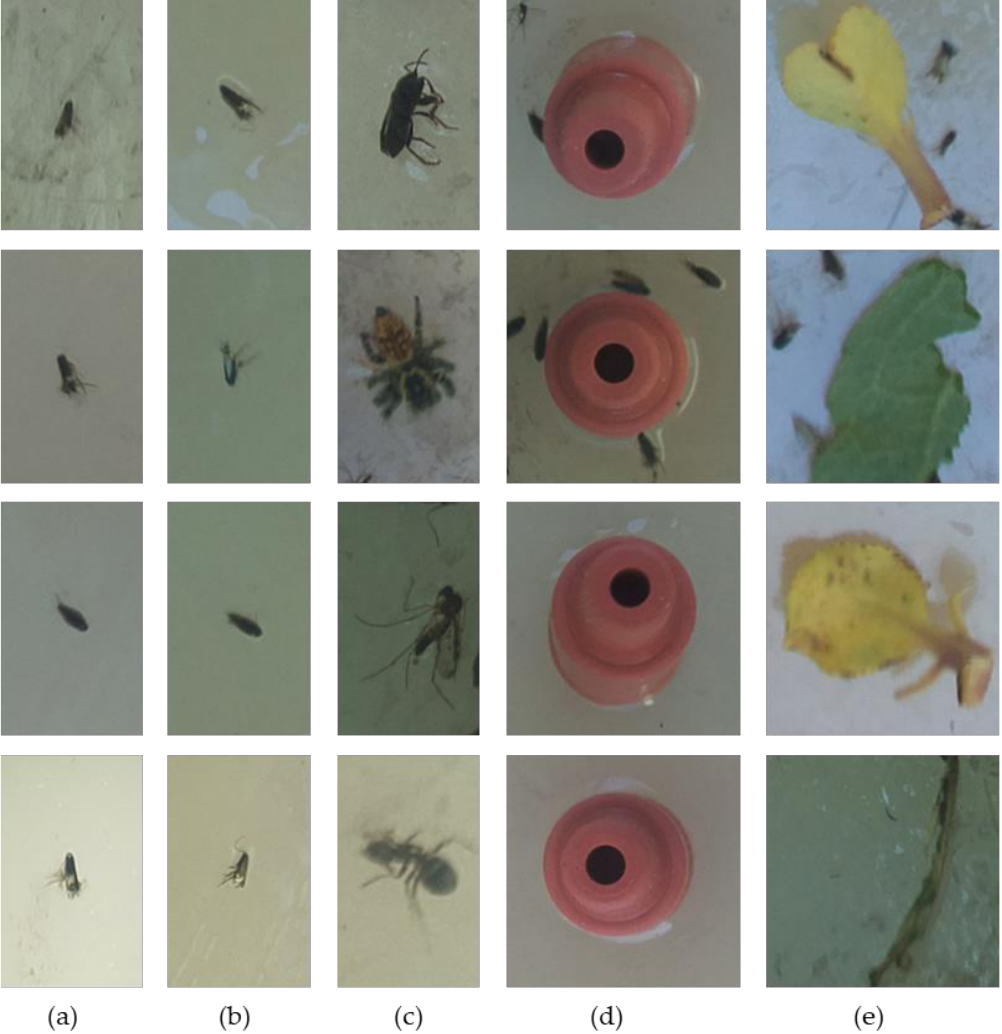
Figure 4. Examples of typical pest trap image segments with sizes of 55 × 90 pixels and 90 × 90 pixels include L. malifoliella adults ( a , b ); other insects ( c ); pheromone lure for L. malifoliella ( d ); other objects on adhesive pads (dirt, remains of leaves, branches, etc.) ( e ).